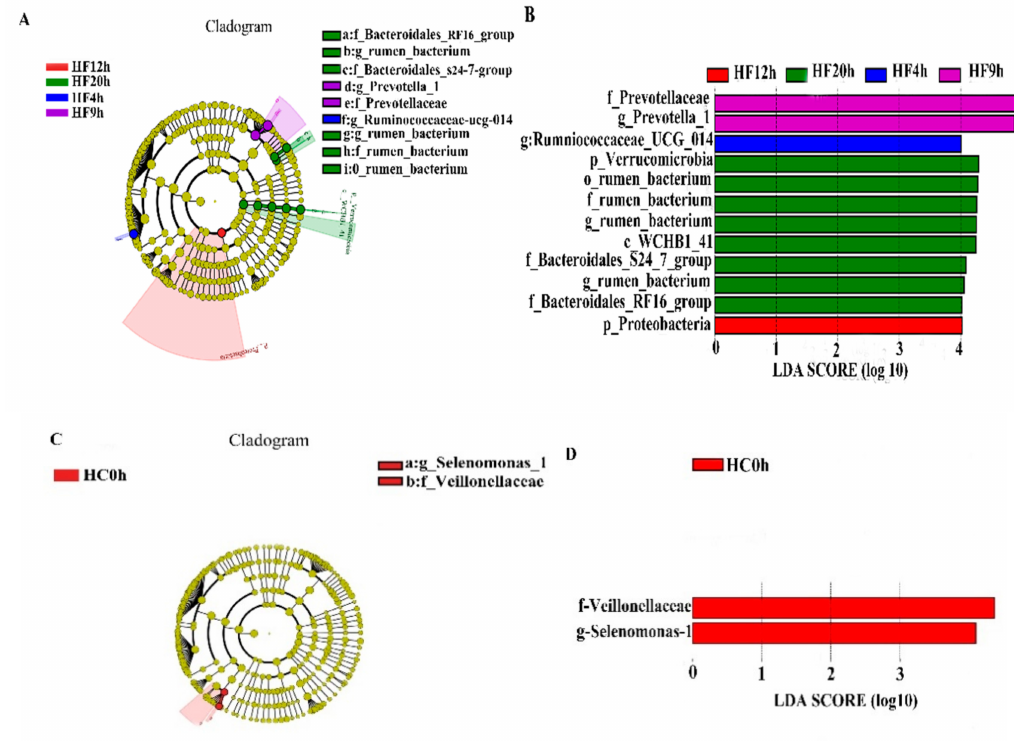
Figure 5. LefSe analysis. ( A , C ) The cladogram diagram shows the microbial species with significant di ff erences in the HF ( A ) and HC ( C ) dietary treatments. The di ff erent colors indicate di ff erent groups, with the species classifications at the levels of phylum, class, order, family and genus shown from the inside to the outside. ( B , D ) Species with significant di ff erences that have an linear discriminant analysis (LDA) score greater than the estimated value; the default score is 4.0 and 3.0 in the HF ( B ) and HC ( D ) dietary treatments, respectively. The length of the histogram represents the LDA score, i.e., the degree of influence of the species with the significant di ff erences between the di ff erent